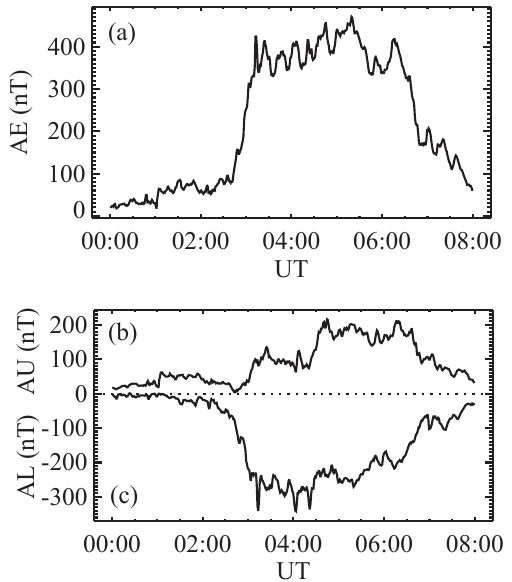
Figure 1. (a) AE, (b) AL and (c) AU indices recorded on 3 Jan- uary 2001.